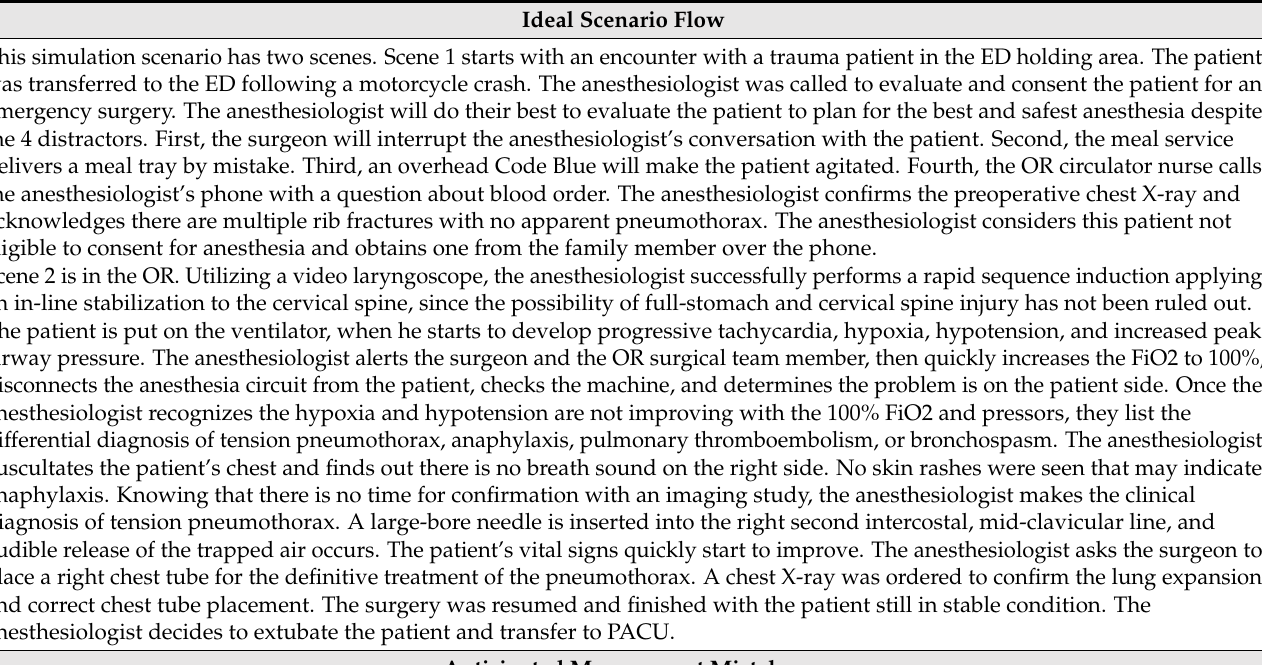
Table A4. Instructor Notes—Ideal Scenario Flow and Anticipated Management